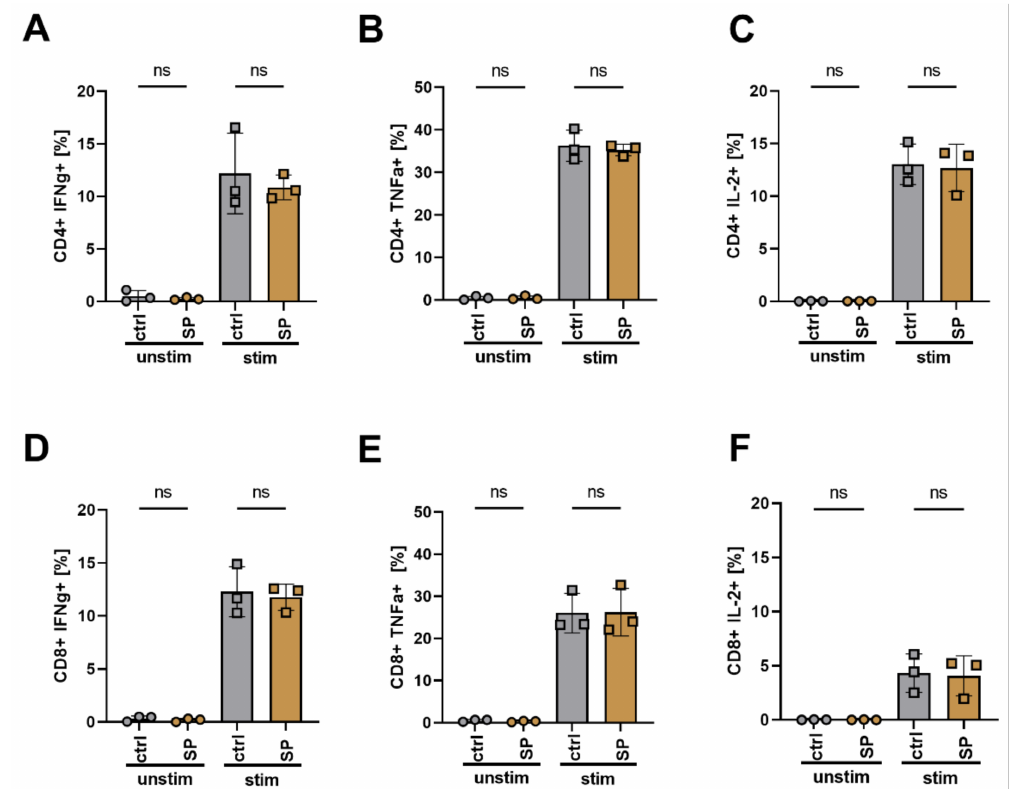
Figure 6. Cytokine expression of T cells after stimulation. Isolated T cells were loaded with 80 µ g Fe/mL SPIONs and were stimulated with a CD3/CD28/CD2 activation mix overnight. H 2 O treated cells and cells without stimulation mix served as controls. The cells were then stained for CD4 and CD8, viability, and cytokine expression. Depicted are the percentages of CD4 ( A – C ) or CD8 ( D – F ) T cells expressing TNF α ( A , D ), IFN γ ( B , E ) or IL-2 ( C , F ). Statistical significances were estimated using an unpaired t test with Welch’s correction; (ns): p ≥ 0.05. ctrl: control; SP: SPIONs; unstim: unstimulated T cells; stim: stimulated T